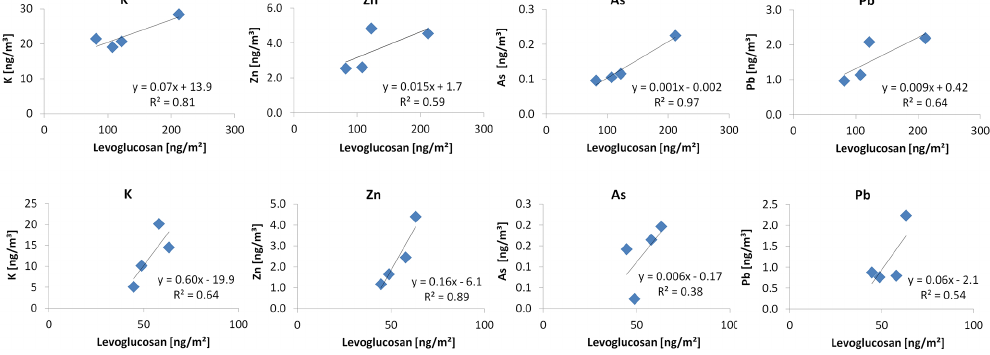
Figure 2. Scatter plots of levoglucosan, a biomass burning tracer, and K, Zn, As and Pb, in PM 1 . 2 particulate matter at (a) upwind GL and (b) downwind GB stations during HCCT2010.